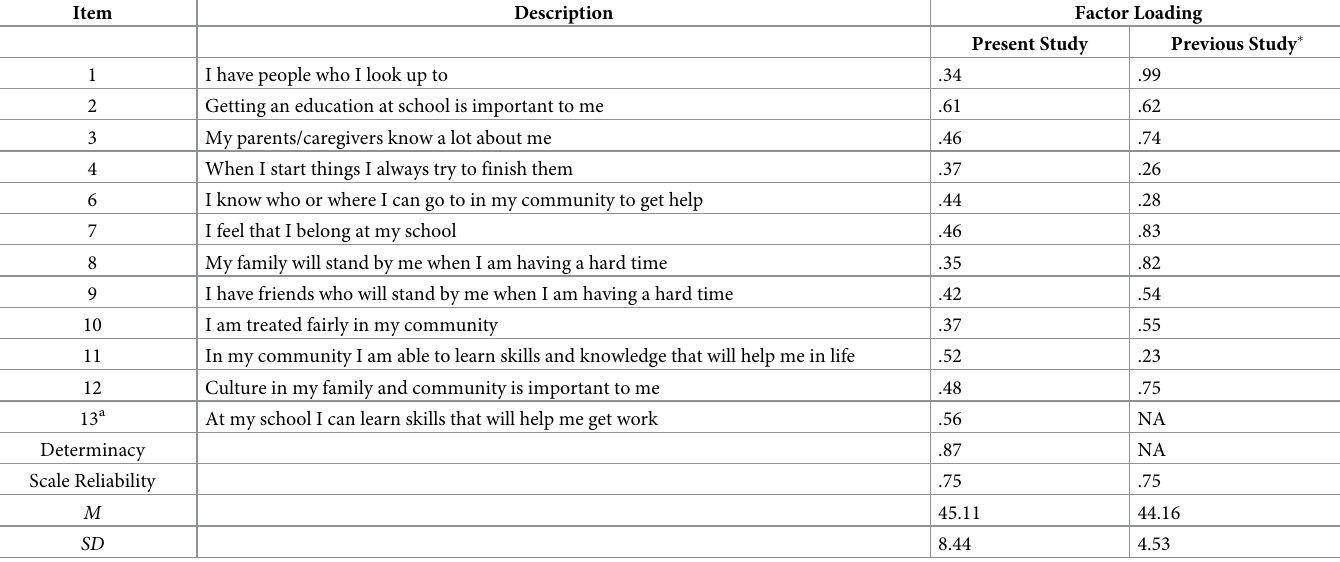
Table 3. Confirmatory factor analysis of the 12-item Child and Youth Resilience Measure (CYRM-12NT): Psychometric comparisons with Liebenberg et al., 2013